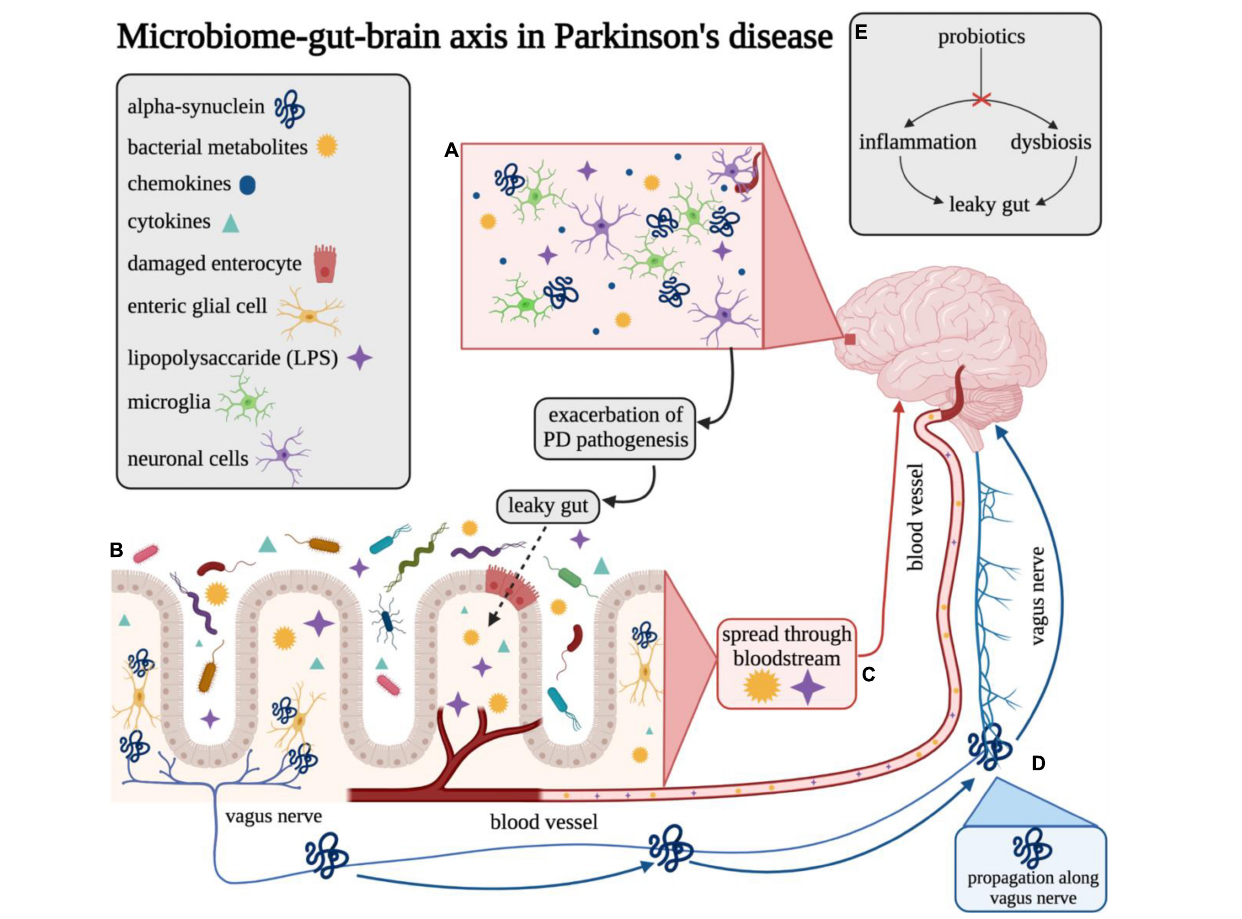
FIGURE 1 | Overview of the gut–brain axis in Parkinson’s disease. Visual overview of the proposed microbiome–gut–brain axis in Parkinson’s disease. (A) LPS and other bacterial metabolites may be able to enter the brain across the blood–brain barrier (BBB) and may elicit release of various chemokines/cytokines that promote an inflammatory response in Parkinson’s disease. (B) Microbes in the gut lumen can promote inflammatory pathways and cause damage to enterocytes which may lead to compromised gut epithelial barrier integrity (“leaky gut”). (C) Bacterial metabolites, such as LPS, can translocate from the gut lumen to the bloodstream across the compromised gut barrier and cause possible systemic and neuroinflammation in the brain. (D) Misfolded α -synuclein may be induced by microbes at the intersection of the gut lumen and ENS and may be propagated to neurons in the brain through the vagus nerve. (E) Probiotic interventions are thought to reverse dysbiosis through altering the composition of the microbiome. This change is also purported to result in reduction of inflammation and improvement of gut epithelial barrier integrity, thereby preventing or reducing microbial translocation. This figure was created with